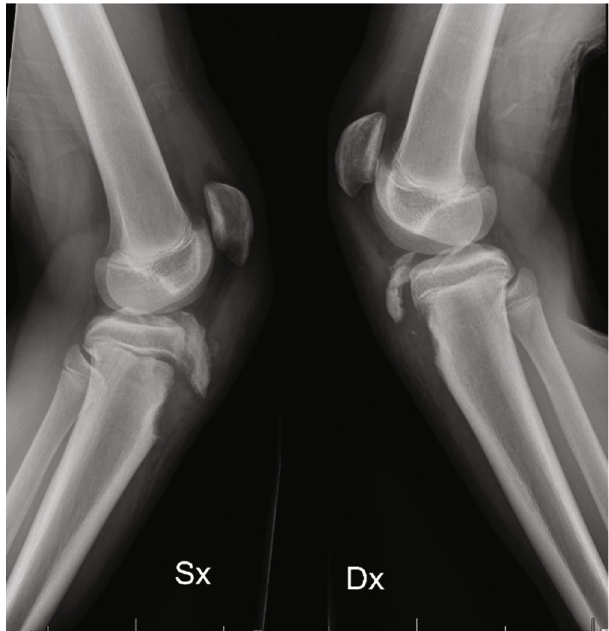
Figure 1: Case I: X-ray imaging showing asymmetrical bilateral tibial tuberosity avulsions with a type IIB of the right knee and type III B of the left, without intra-articular involvement.